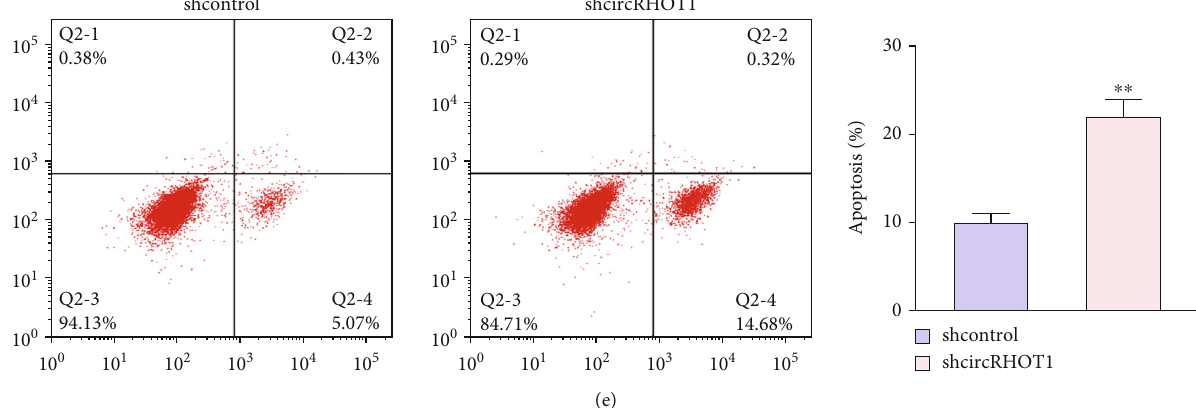
Figure 3: CircRHOT1 contributes to the proliferation of chondrocytes. (a) – (e) The chondrocytes were treated with circRHOT1 shRNA. (a) The expression of circRHOT1 was measured by qPCR. (b) The cell viability was detected by CCK-8 assays. (c) The cell proliferation was analyzed by colony formation assays. Magni fi cation, × 20. (d) The cell cycle was determined by FACS fl ow cytometer. (e) The cell apoptosis was assessed by FACS fl ow cytometer. Mean ± SD , ∗∗ P < 0 : 01